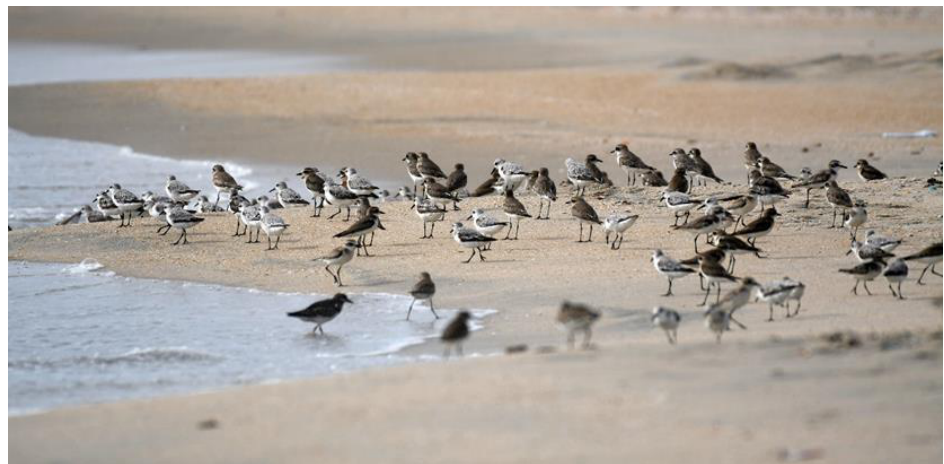
Figure 2. Lesser Sand Plover ( C. mongolus ), Sanderling ( C. alba ) and Ruddy Turnstone ( A. interpres ) at Puthiyappa beach in the west coast of India — Photo courtesy: C.T. Shifa.